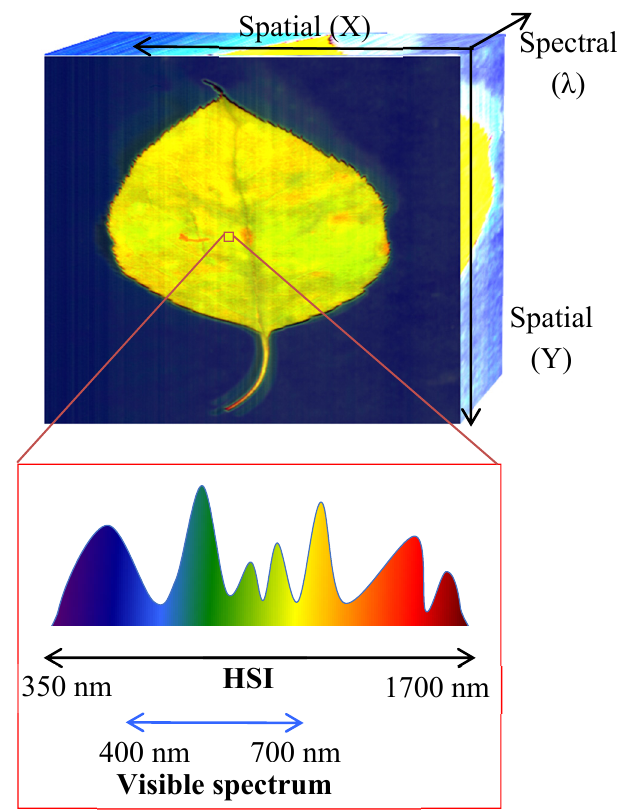
Figure 1. Mockup of a hyperspectral datacube (a) and corresponding wavelength for a particular pixel (b) [13–15].